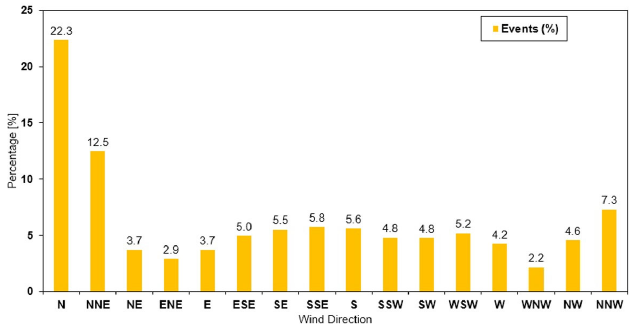
Figure 6. Distribution of wind direction.